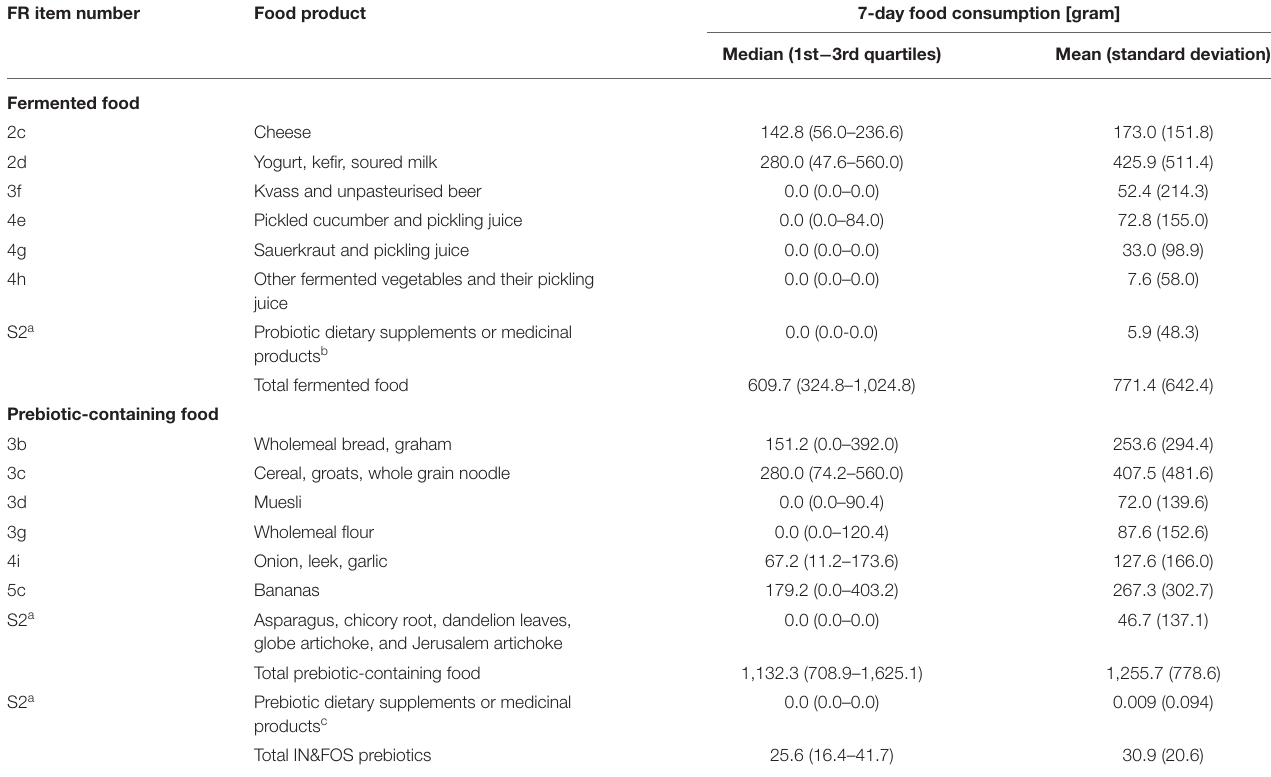
TABLE 2 | Pre-exam 7-day consumption of fermented and prebiotic-containing food, and food-derived prebiotics (number of subjects assessed = 372). FR item